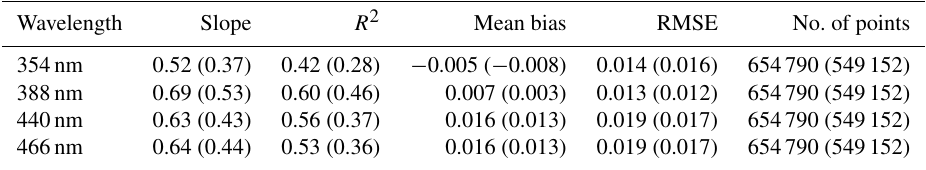
Table 2. Statistical analysis of GLER vs. OMI LER for nonsunglint scenes. January (July) 2006 deep ocean only with MODIS GCF = 0.0 (corresponds to the first and third column of Fig. 1).